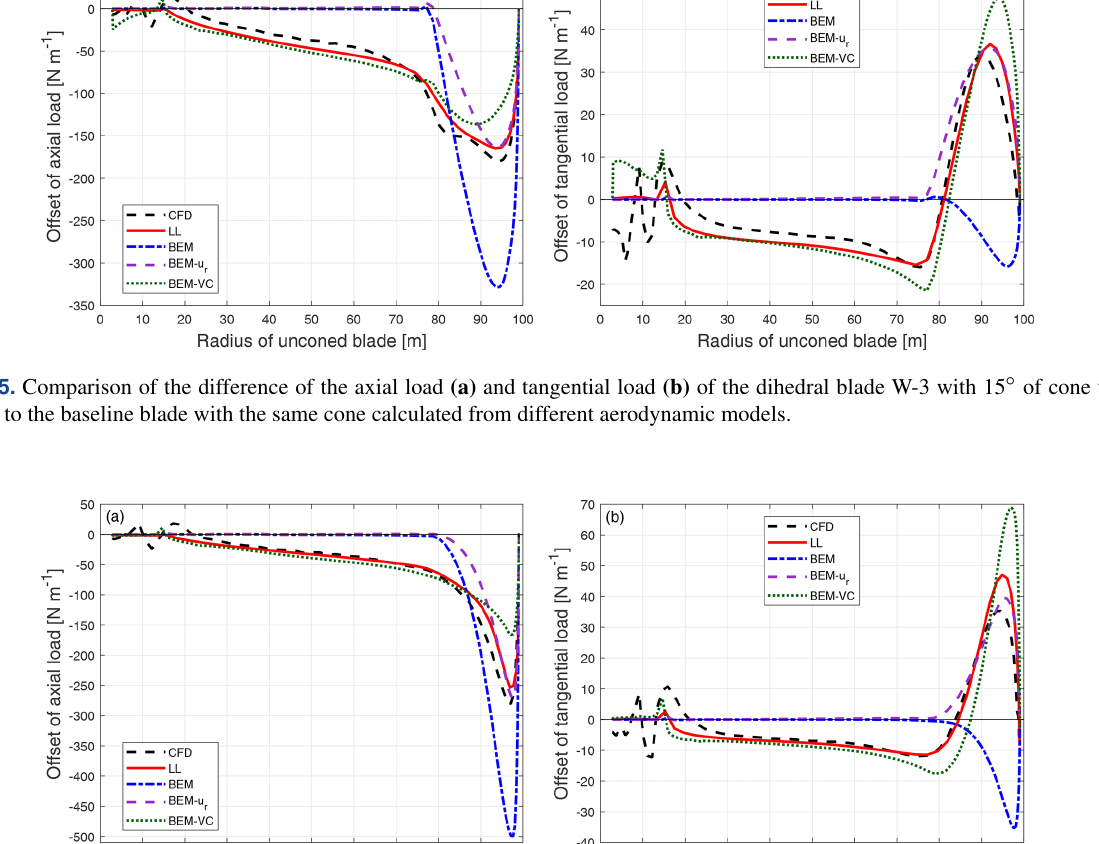
Wind Energ. Sci., 7, 75–104,